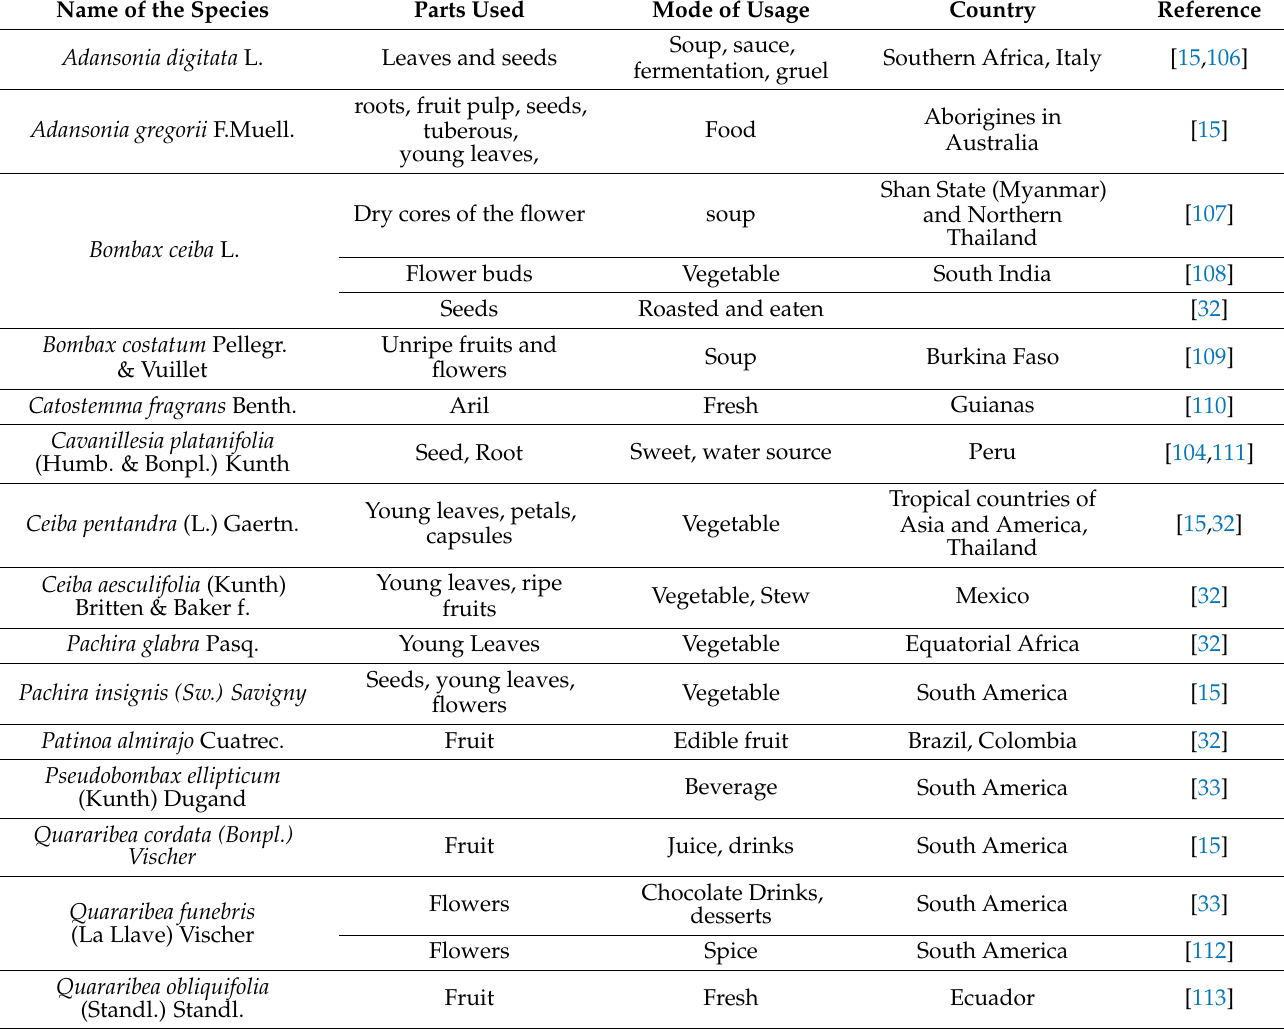
Table 3. Plant and parts used as a